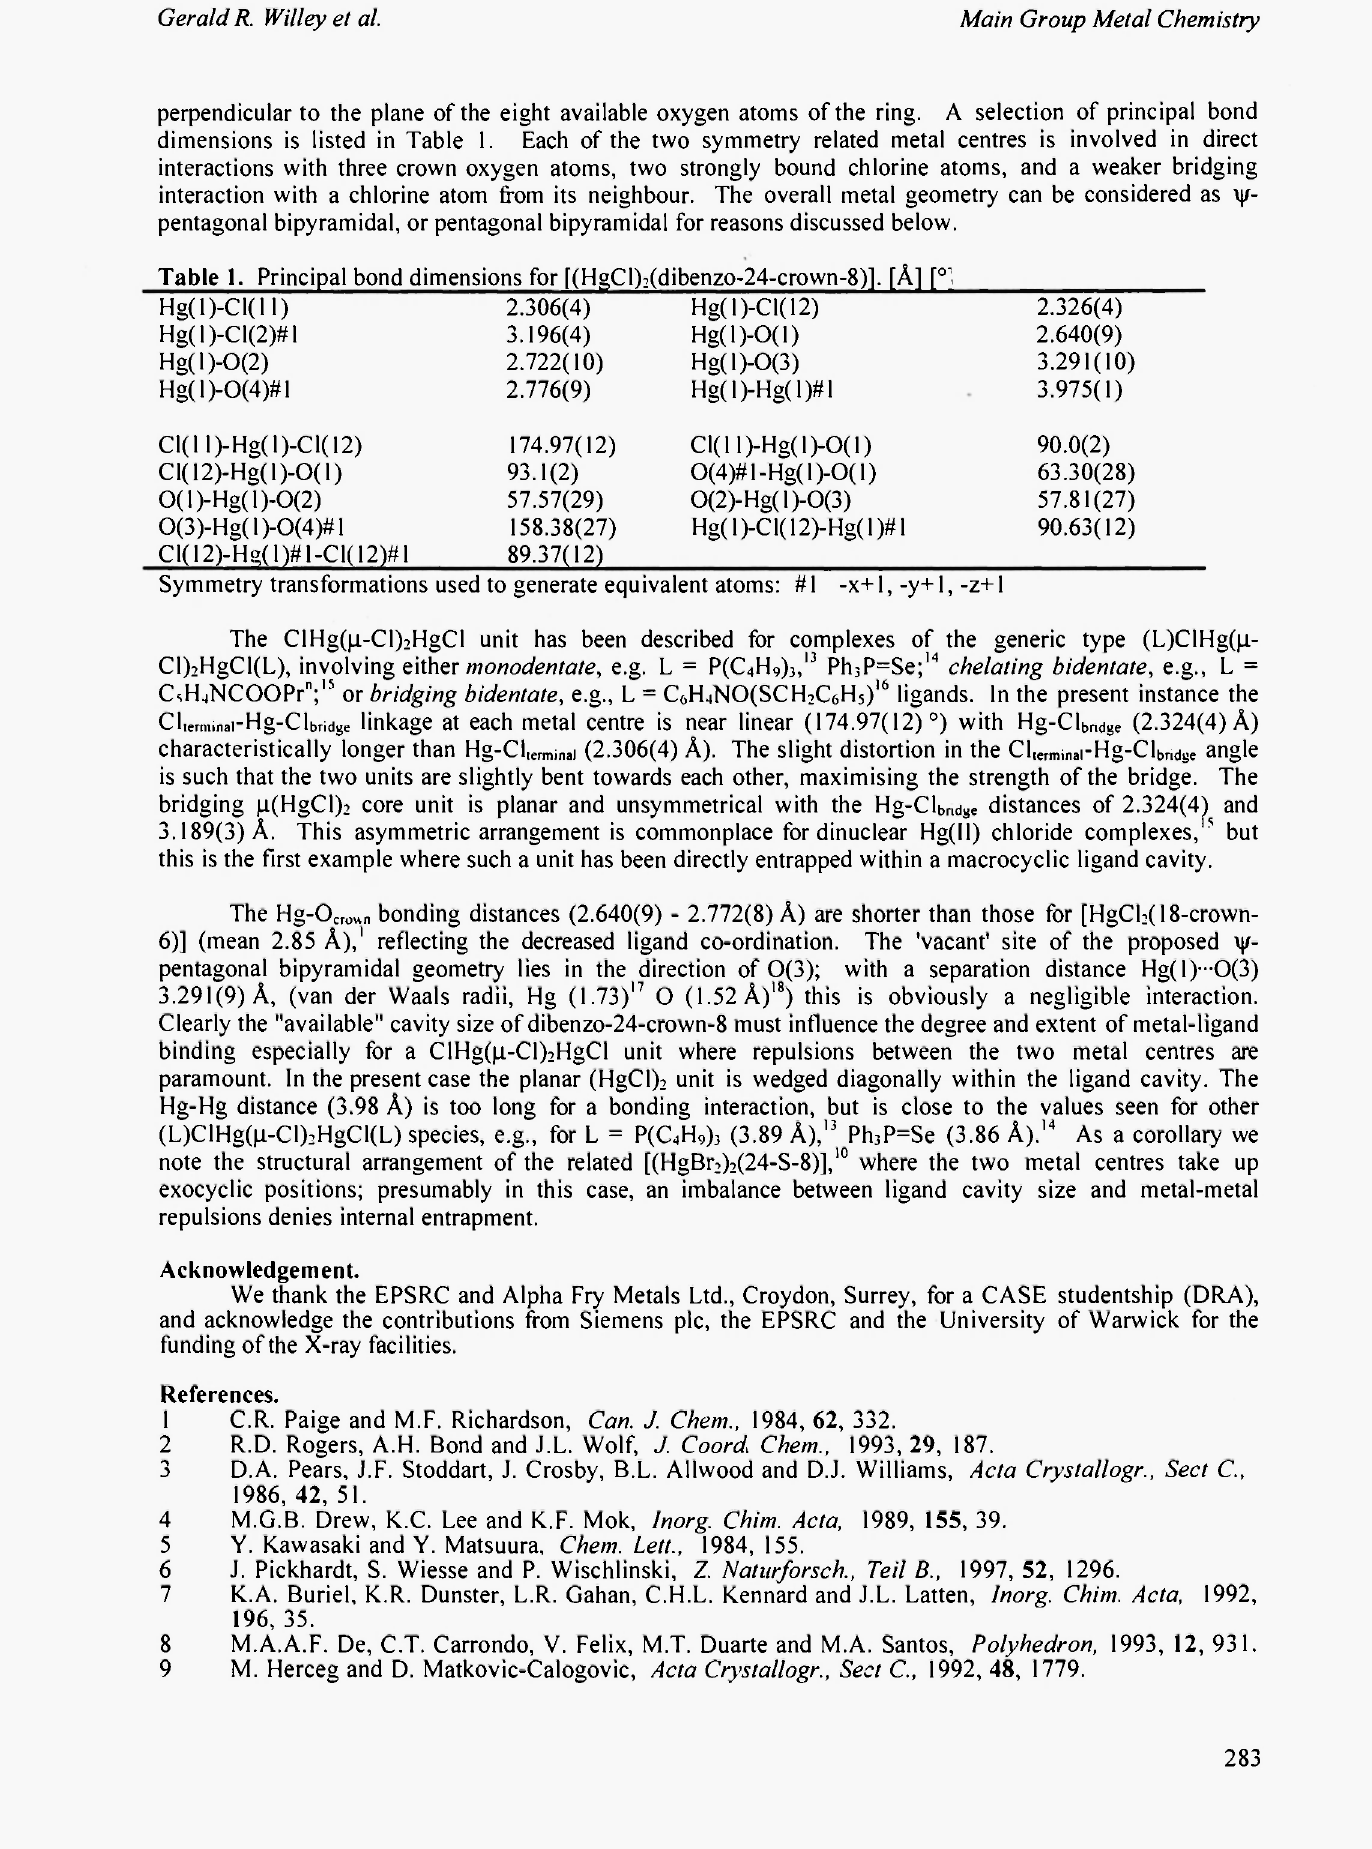
Table 1. Principal bond dimensions for KHgCl) 2 (dibenzo-24-crown-8)]. [A] [